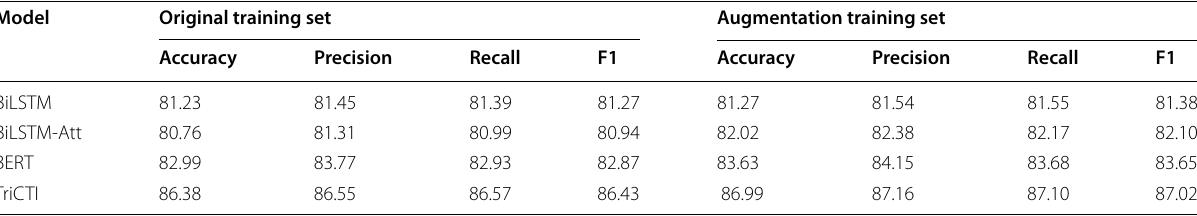
We run the model on the original labeled training set and the augmented training set. Accuracy, Precision, Recall, and F1 score (macro) are the average value over 3 runs Table 3 Ablation study results